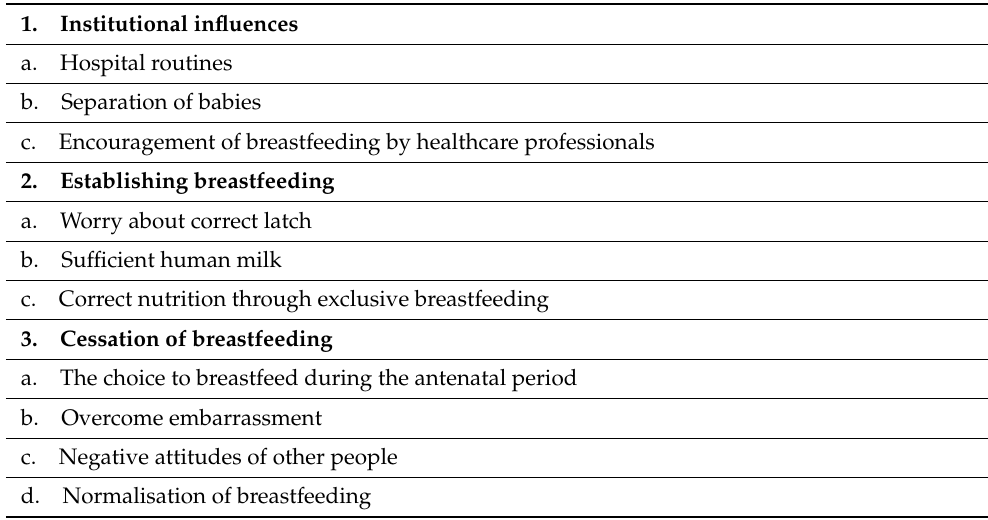
Table 2. Theme clusters and theme